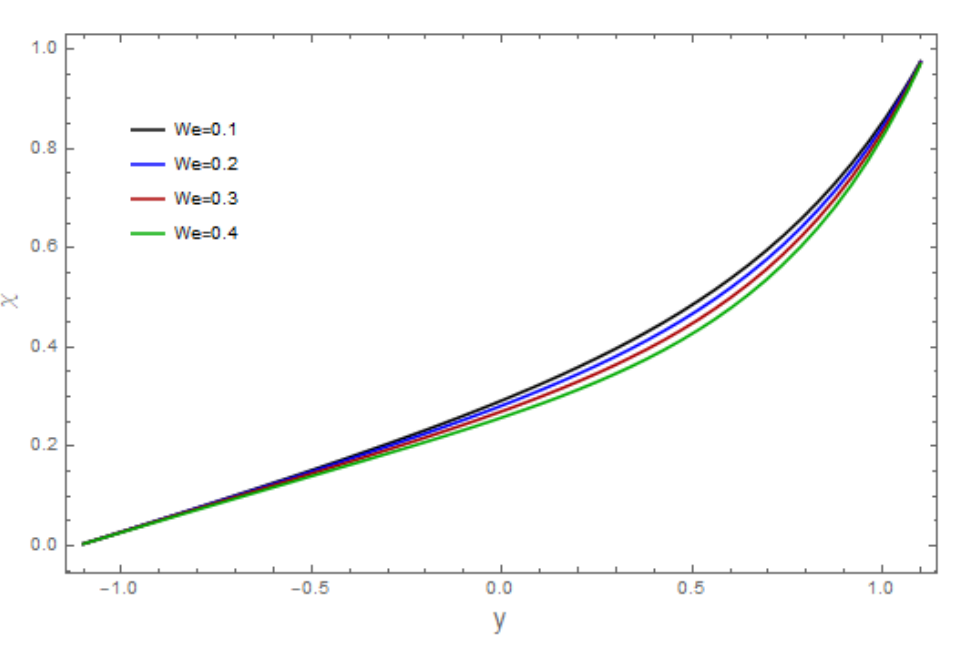
Figure 22. Effect of 𝑊𝑒 on 𝜒 .